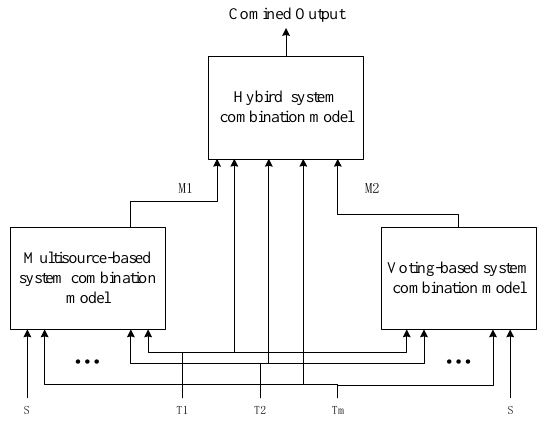
Figure 4. The architecture of the hybrid system combination framework.